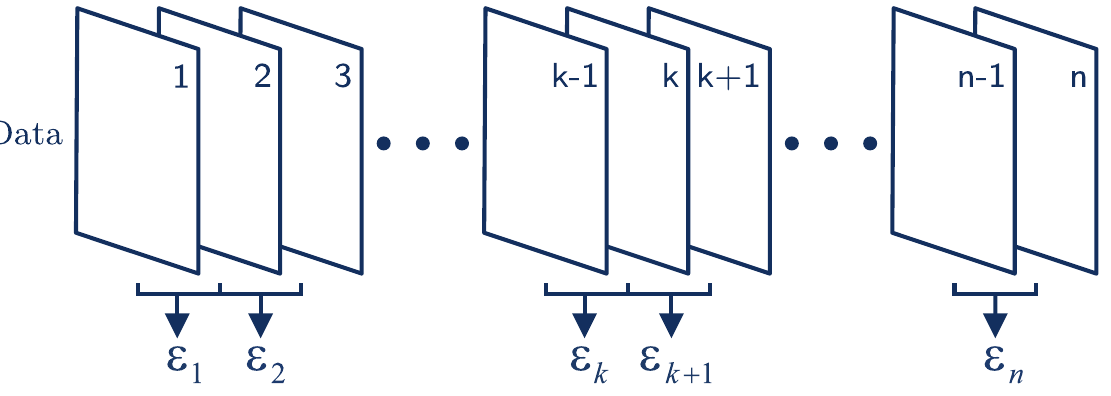
Figure 7. The frame pairing method for strain computation